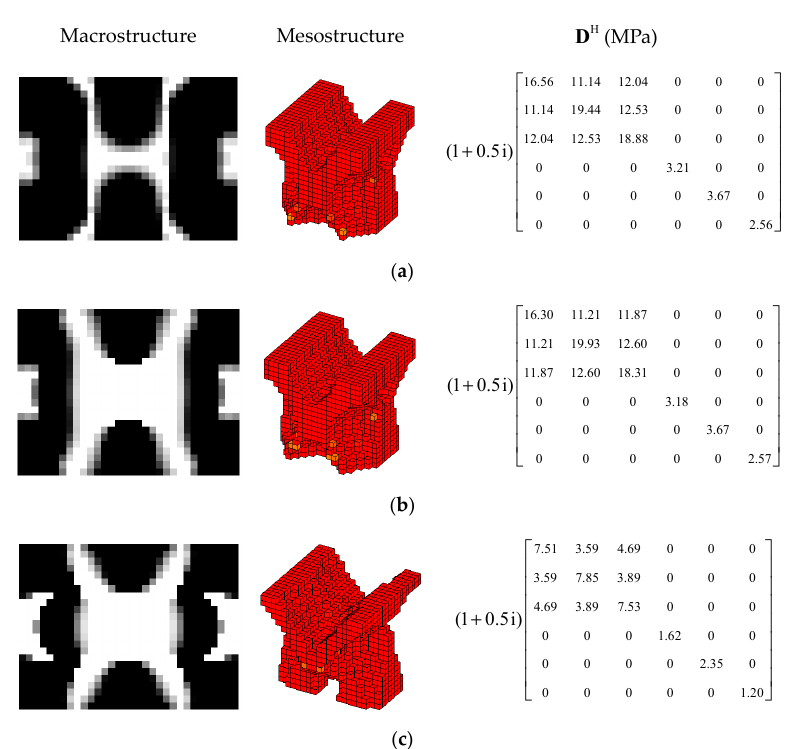
Figure 24. Design results for maximizing the second modal loss factor: ( a ) Case 4: V MA